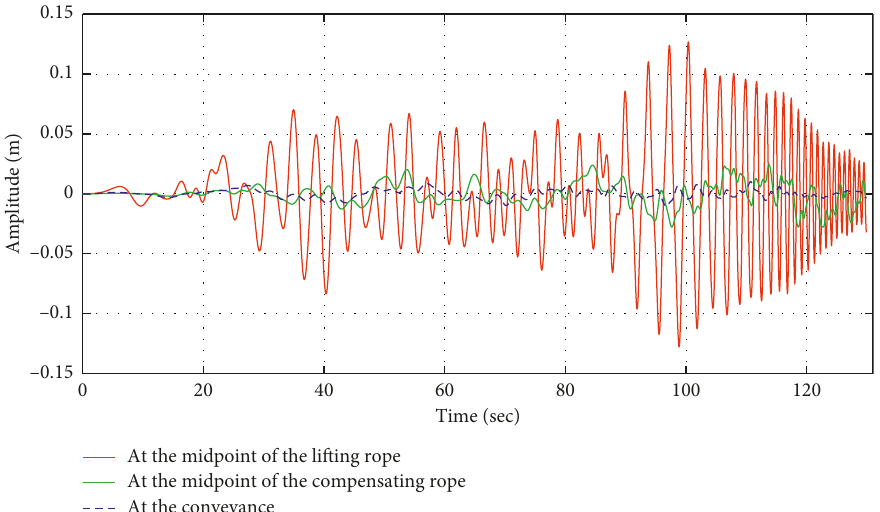
Figure 10: Transverse vibration responses at the midpoint of the lifting rope, midpoint of the compensating rope, and conveyance.